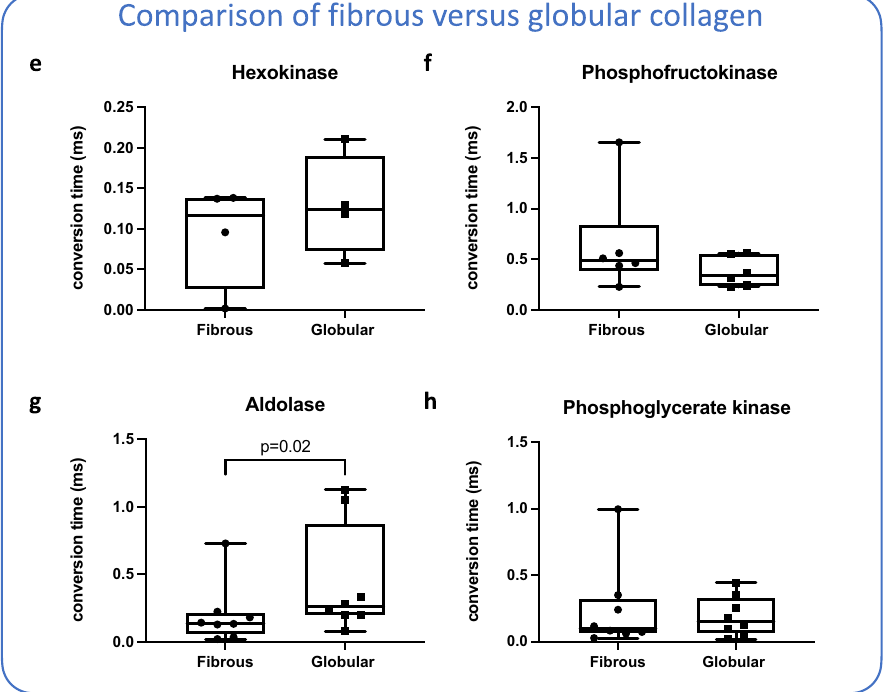
Figure 5. Activity of key glycolytic enzymes in alveolar macrophages in different culture conditions. Macrophages were cultured in wells coated with either fibrous or globular collagen or uncoated. After 72 h, enzymatic activity of four different glycolytic enzymes was measured in cell lysates. ( a – d ) Activity of glycolytic enzymes compared between macrophages cultured in uncoated and collagen type I-coated conditions (fibrous and globular pooled). Only the activity of aldolase was significantly lower in collagen-coated conditions. ( e – h ) Activity of glycolytic enzymes compared between macrophages cultured in fibrous collagen-coated and globular collagen-coated conditions. Only the activity of aldolase was significantly higher in globular collagen-coated conditions. Bars represent the mean rate of enzyme activity and each data point represents a different biological replicate (n = 4 for hexokinase, n = 6 for phosphofructokinase, and n = 8 for aldolase and phosphoglycerate kinase). Groups were compared using a Mann–Whitney U test ( a – d ) or Wilcoxon test ( e – h ). p < 0.05 was considered significant. Data represented as a box and whiskers plot, where the box extends from the 25th to 75th percentiles and whiskers from min to max